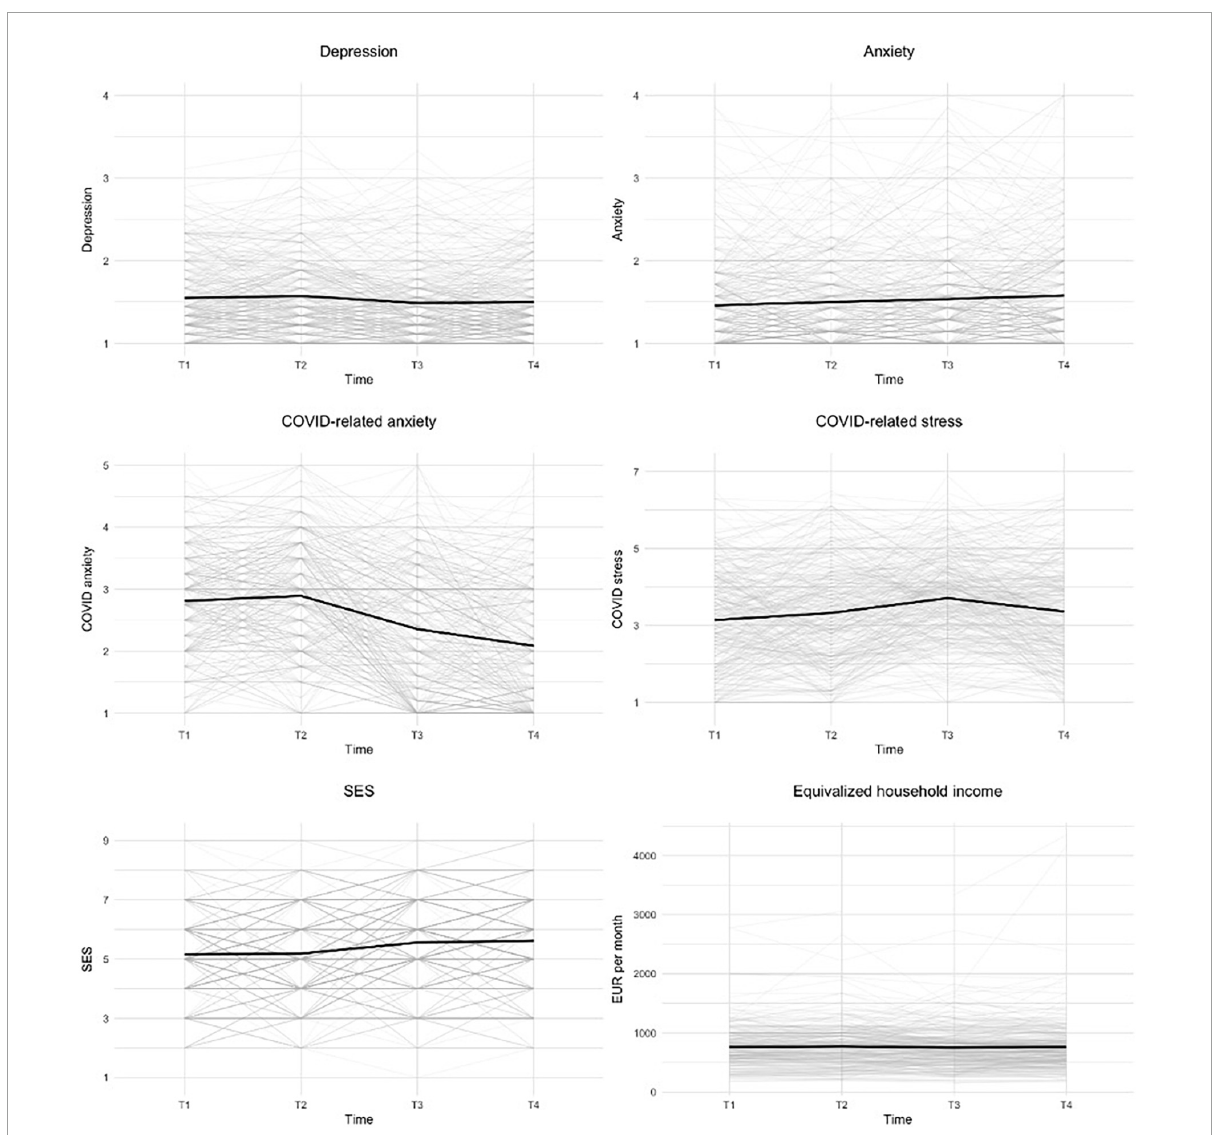
FIGURE2 Visualization of the dynamic of mental health indicators and economic situation. Trend lines for each participant and average trend lines are